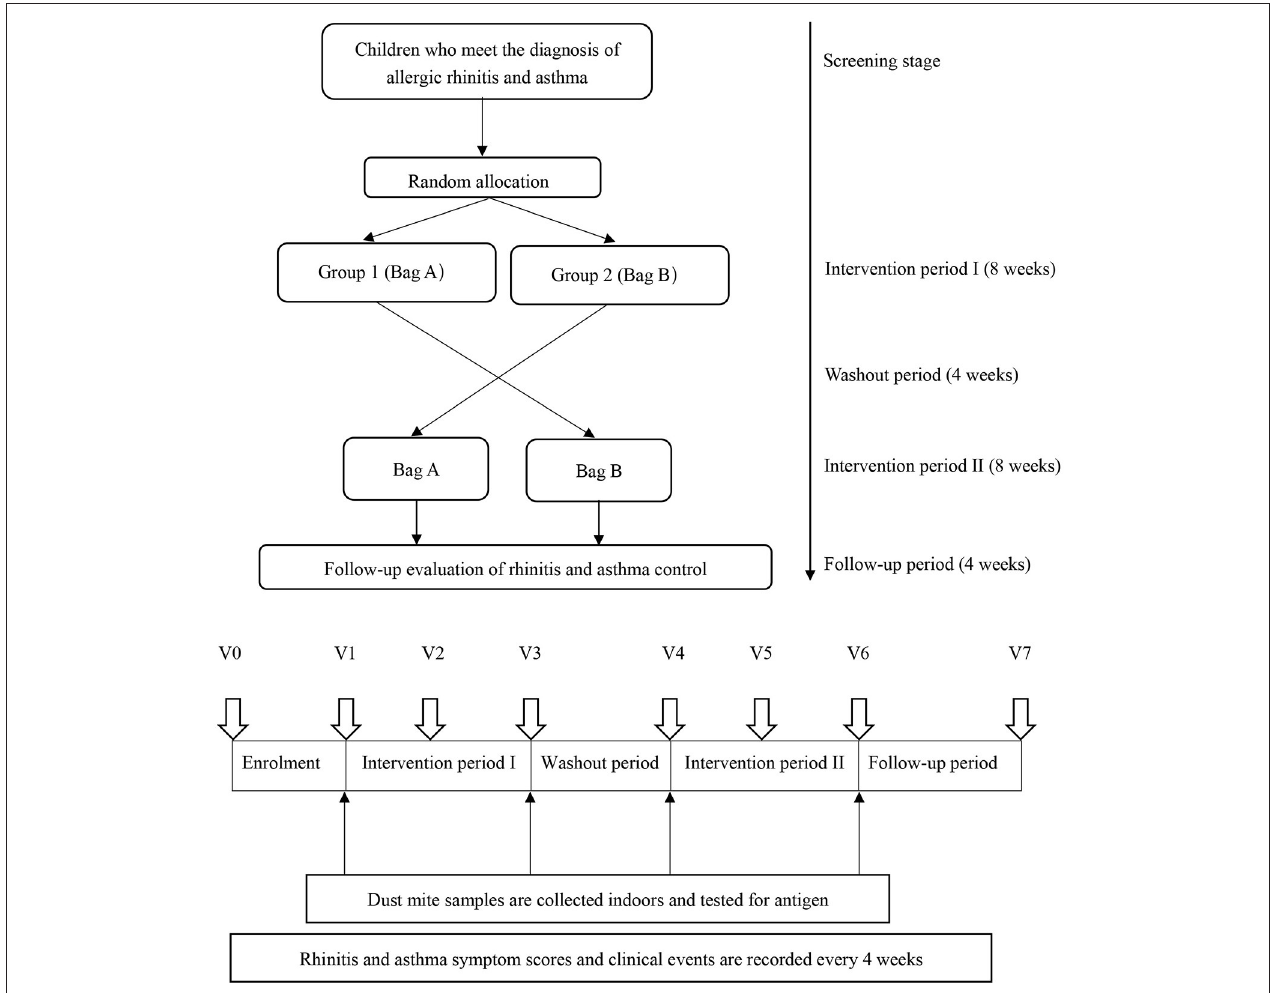
FIGURE 1 | Study design. V0 = before the study began; V1 = the first day after enrolment; V2 = the fourth week plus or minus 3 days after enrolment; V3 = the eighth week plus or minus 3 days after enrolment; V4 = the twelfth week plus or minus 3 days after enrolment, V5 = the sixteenth week plus or minus 3 days after enrolment, V6 = the twentieth week plus or minus 3 days after enrolment; V7 = the twenty-fourth week plus or minus 3 days after